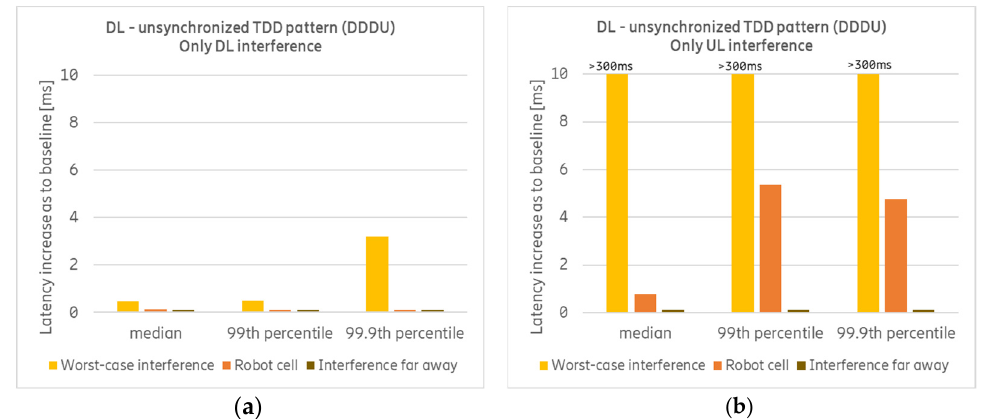
Figure 7. Increase in DL latency compared to baseline for unsynchronized TDD pattern (indoors: DDDU, outdoors: DDDDU) and different indoor/outdoor UE deployment locations. ( a ) Result for only DL interference (near–far interference). ( b ) Result for only UL interference (cross-link interference).